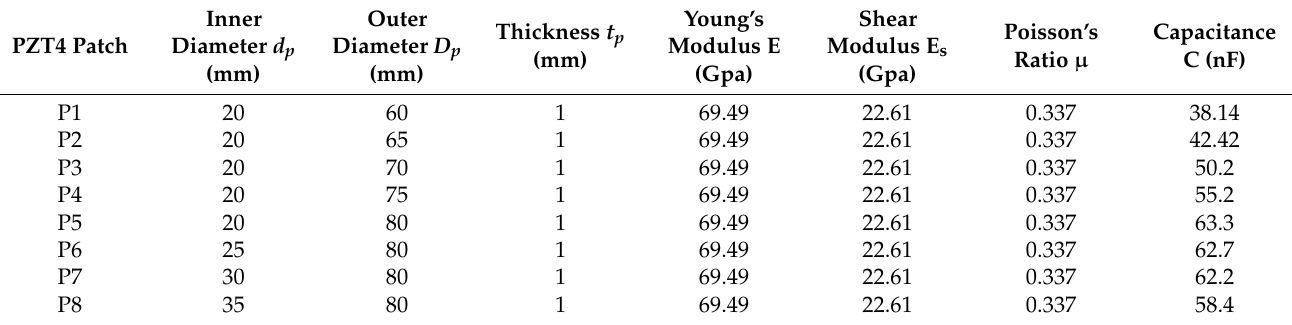
Table 2. Dimensions and physical parameters of PZT4 patches.